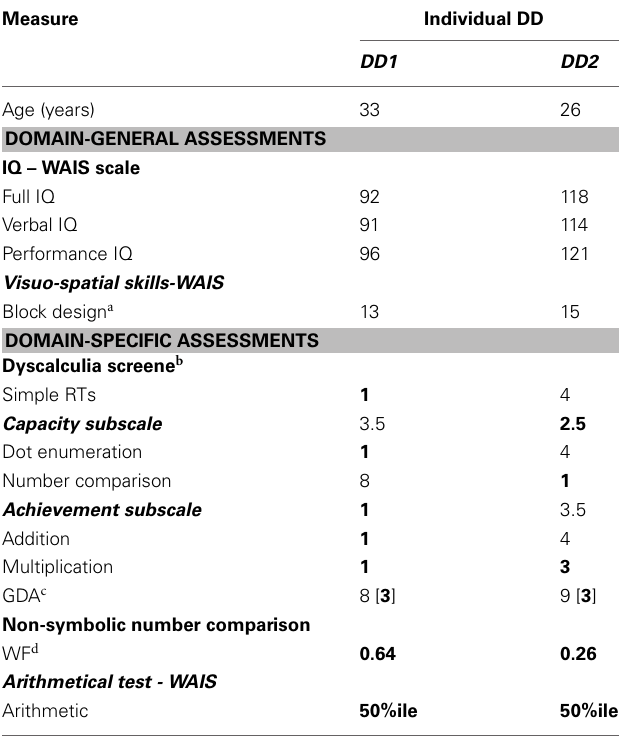
Table 1 | Demographic, IQ, diagnostic and experimental measures of the two DD individuals.